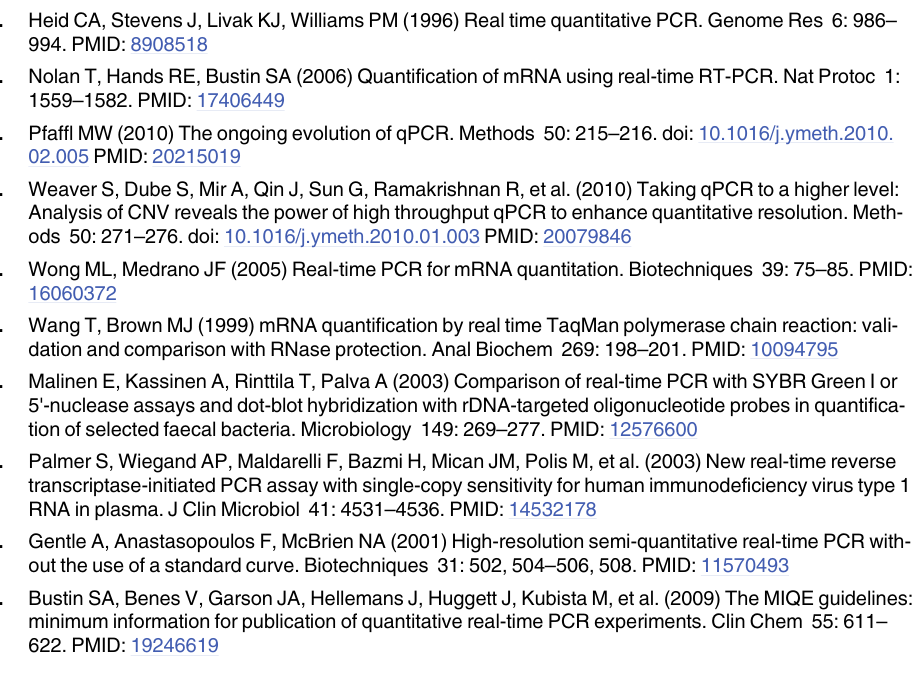
S1 Table. Primers used for PCR analysis. S2 Table. MRQ Primers used for QR